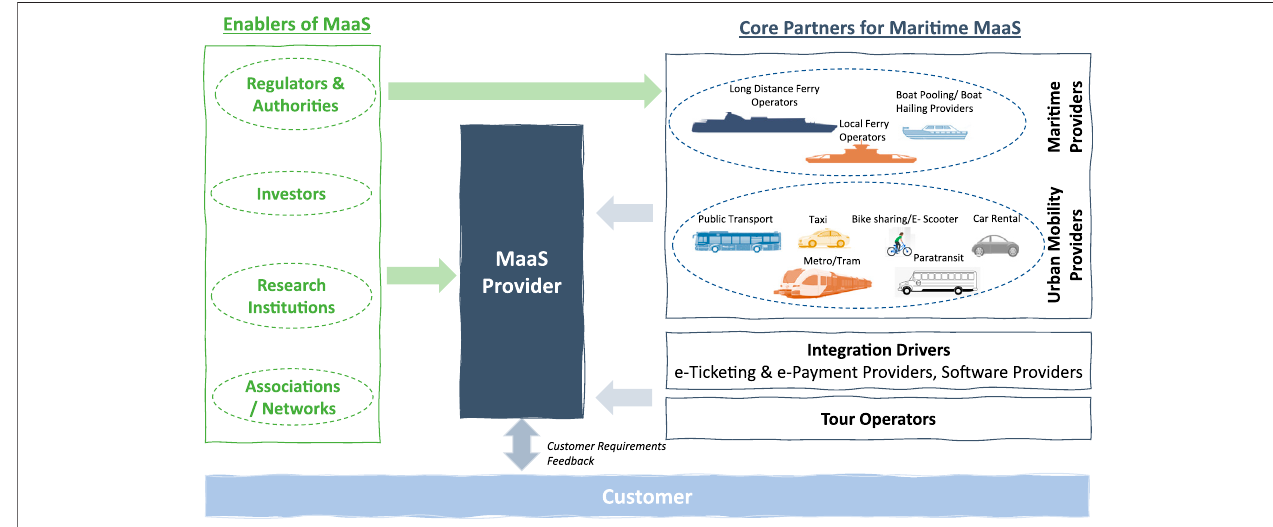
FIGURE 2 | The Maritime MaaS business ecosystem. Source: Own